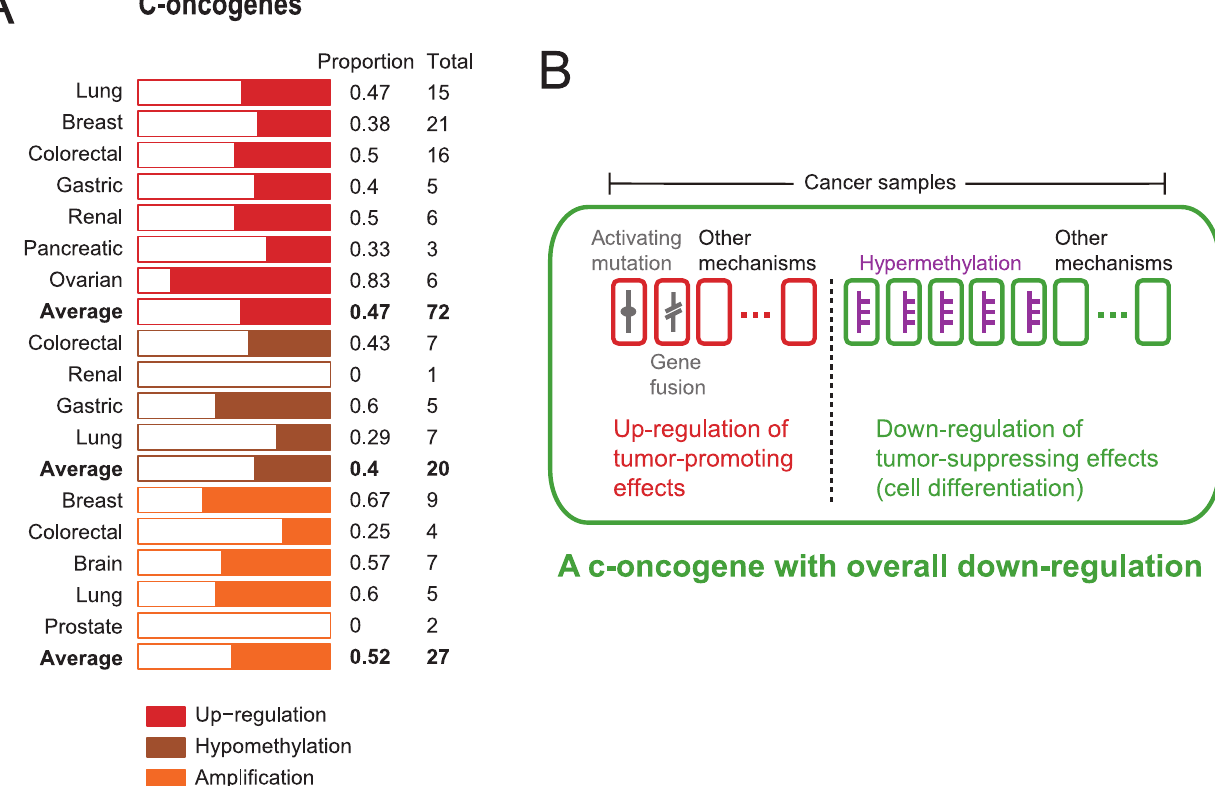
Figure 1. The expression, methylation and copy number changes of C-oncogenes and the related mechanisms. A , Numbers of C- oncogenes with expression, methylation and copy number changes in the corresponding cancer types. A full list of these C-oncogenes is given in Table S4. B , The mechanisms underlying the overall down-regulation of C-oncogenes in cancer patient population.